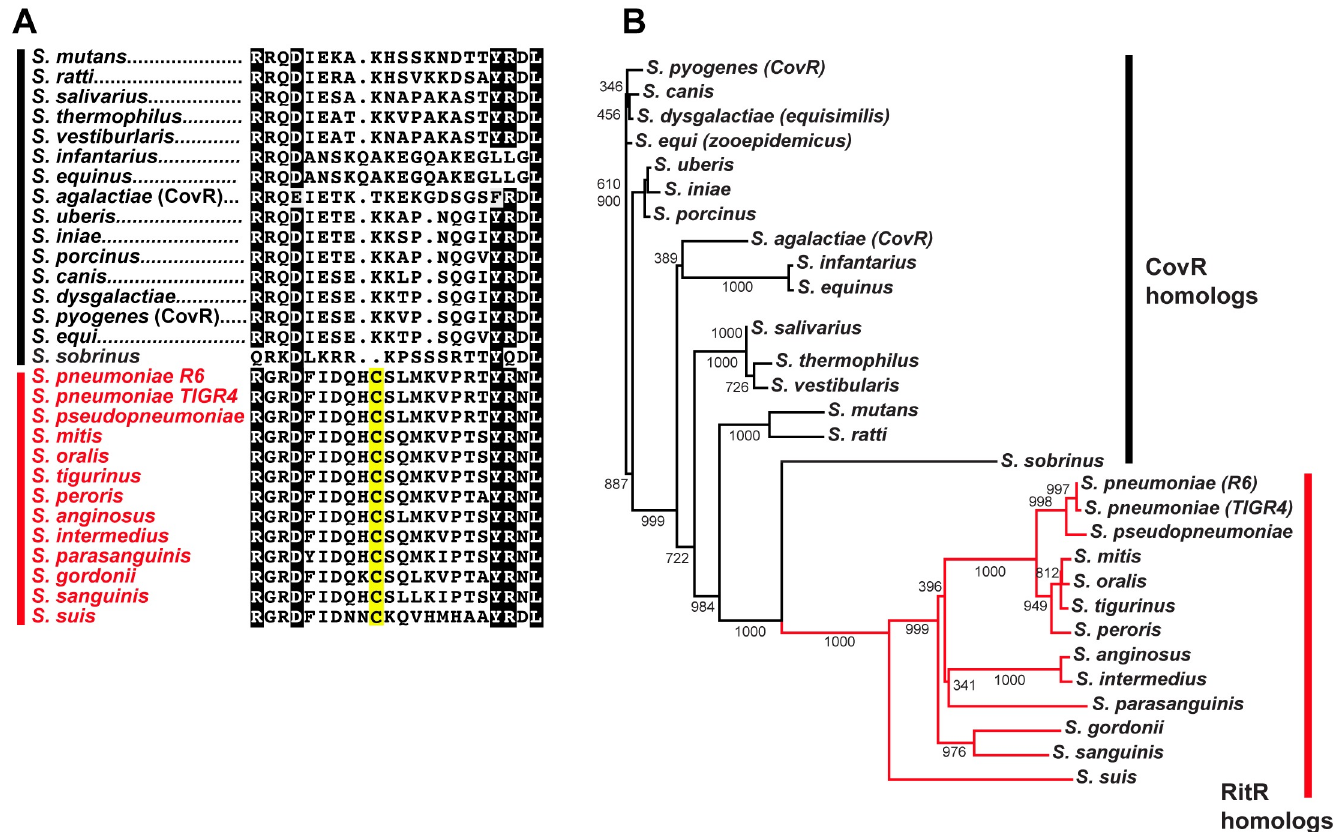
Fig 5. Conservation of RitR in the streptococci. ( A ) Alignment of linker regions of RitR homologs (in red) and CovR homologs (in black) from the streptococci. Notice the degeneracy in the “HCS” motif in the swine zoonotic pathogen S . suis . Identical residues are colored black and similar residues are colored grey. The conserved cysteine is shaded in yellow. ( B ) Phylogenetic tree of RitR (in red) and CovR (in black) streptococcal homologs. Evolutionary distance is depicted by the length of the horizontal lines. Posterior probabilities are displayed at the branch points.